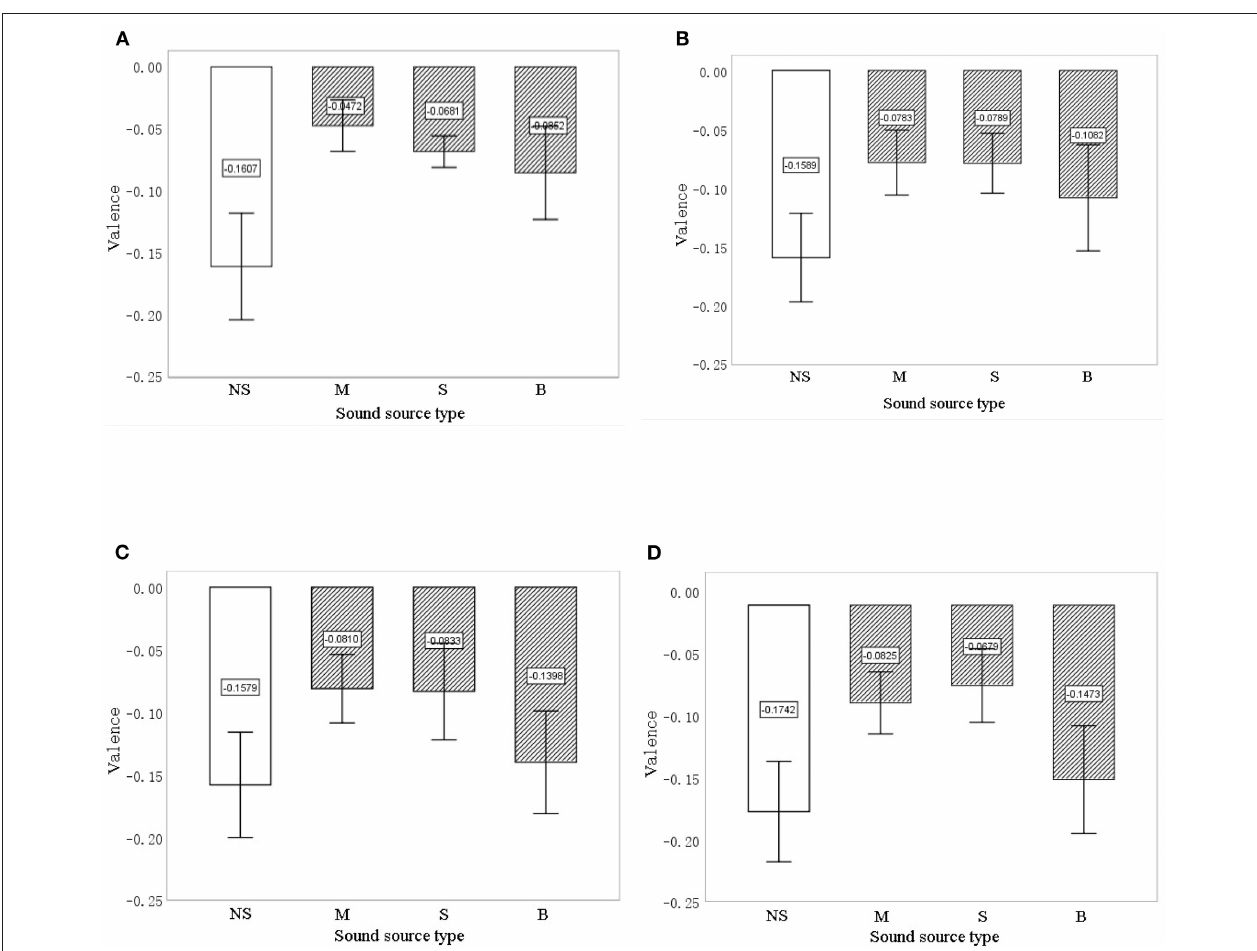
FIGURE 5 | The valence for the different intervention sound types and the no-sound intervention at 20s (A) , 40s (B) , 60s (C) , and 80s (D) . The error bars show 95% CIs. NS, no sound; M, music; S, stream; and B, birdsong.